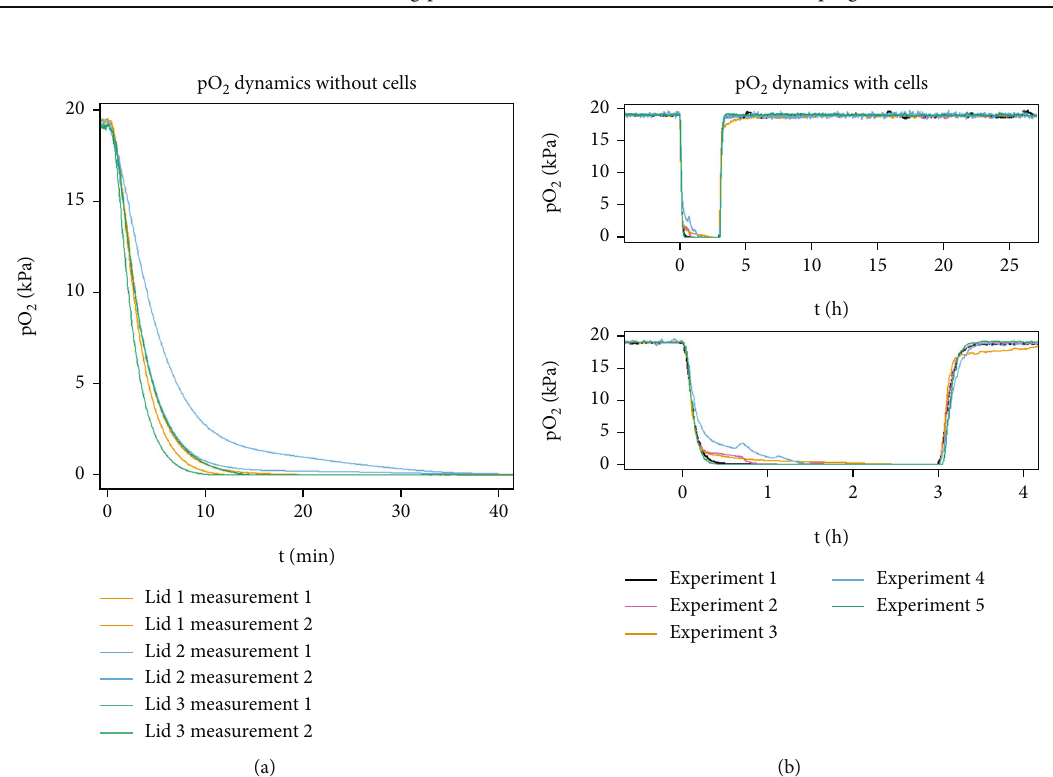
Figure 3: The dynamics of the oxygen partial pressure (pO pressure measurements from 19 kPa to 0 kPa pO Oxygen partial pressure measurements from 19 kPa to 0kPa pO